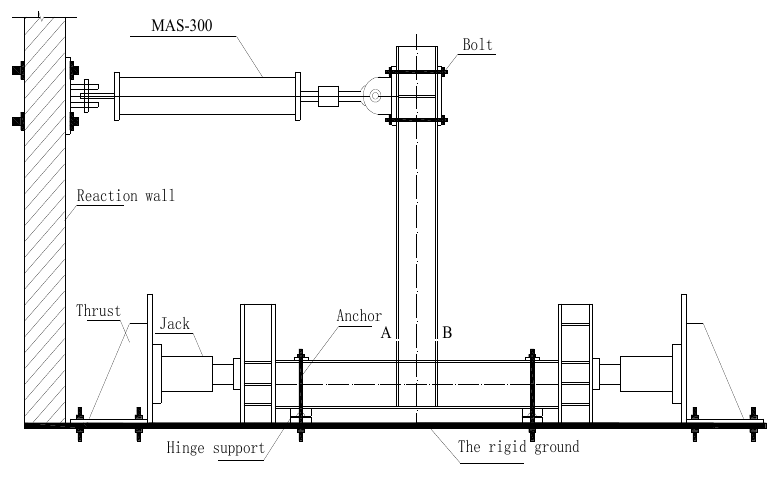
Figure 2. Test setup.